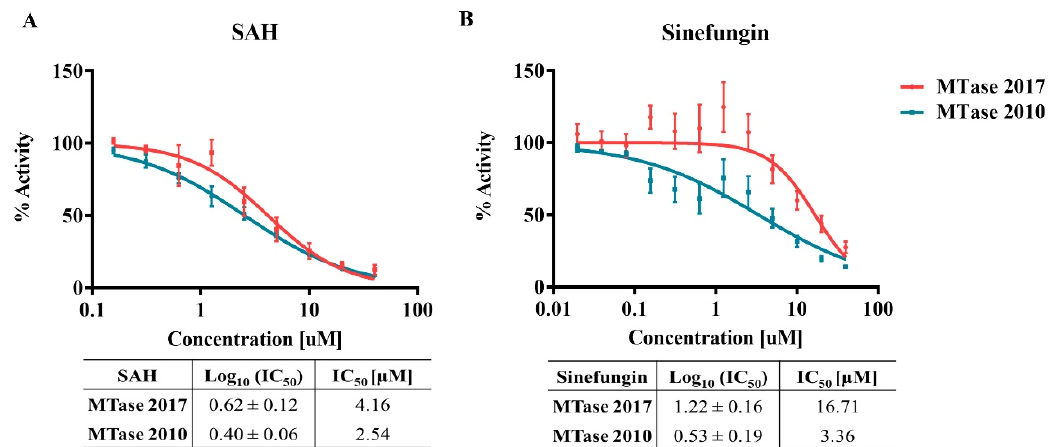
Figure 9. Competition enzymatic assay with the isoforms MTase 2017 and MTase 2010 in the presence of SAM analogs. ( A ) MTase inhibition by SAH and ( B ) Sinefungin. The IC50 values are in the corresponding tables below the graphs.